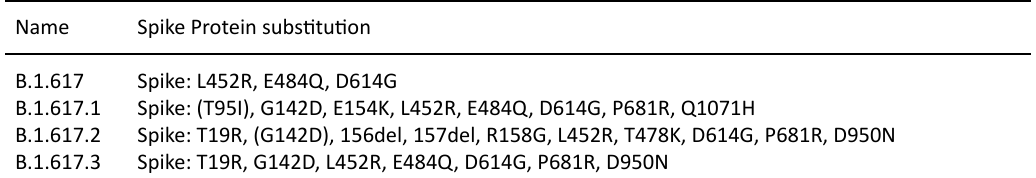
table 2. Novel Coronavirus variant and their spike protein substitution. The data is adopted from Centers for disease control and prevention Name Spike Protein